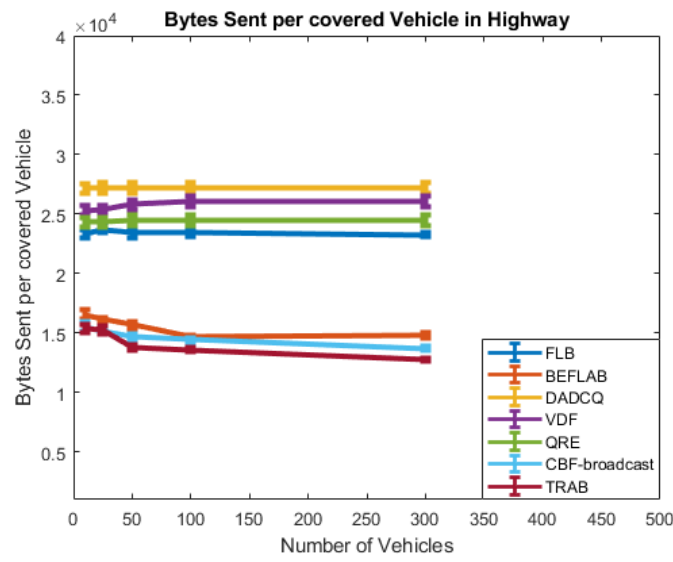
Figure 11. Highway bytes sent per covered